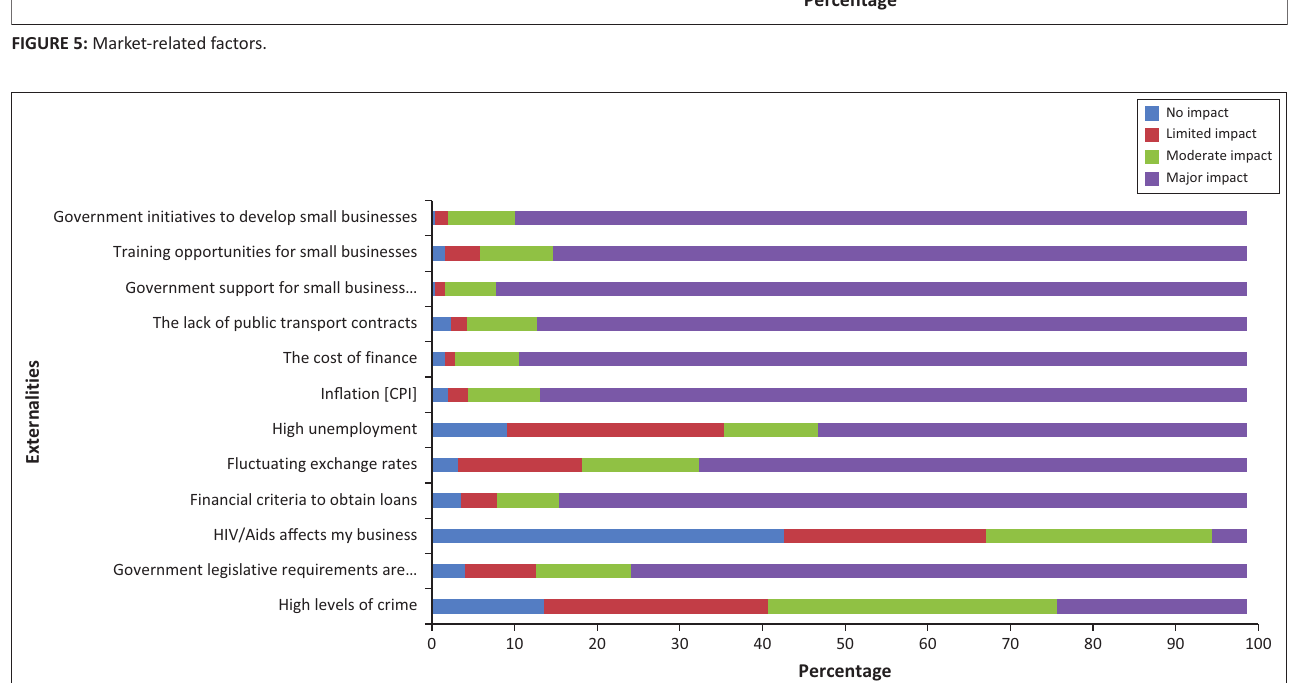
FIGURE 6: Externalities impacting on small-bus operators.